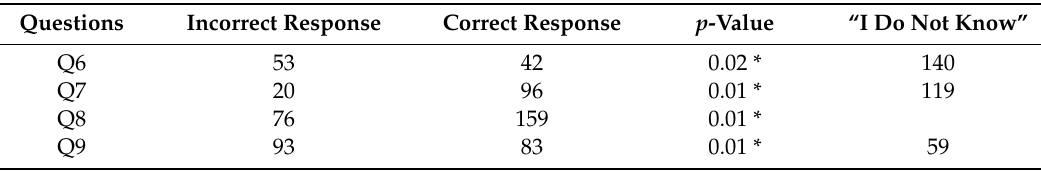
Table 2. Distribution of incorrect and correct response frequency on knowledge-based